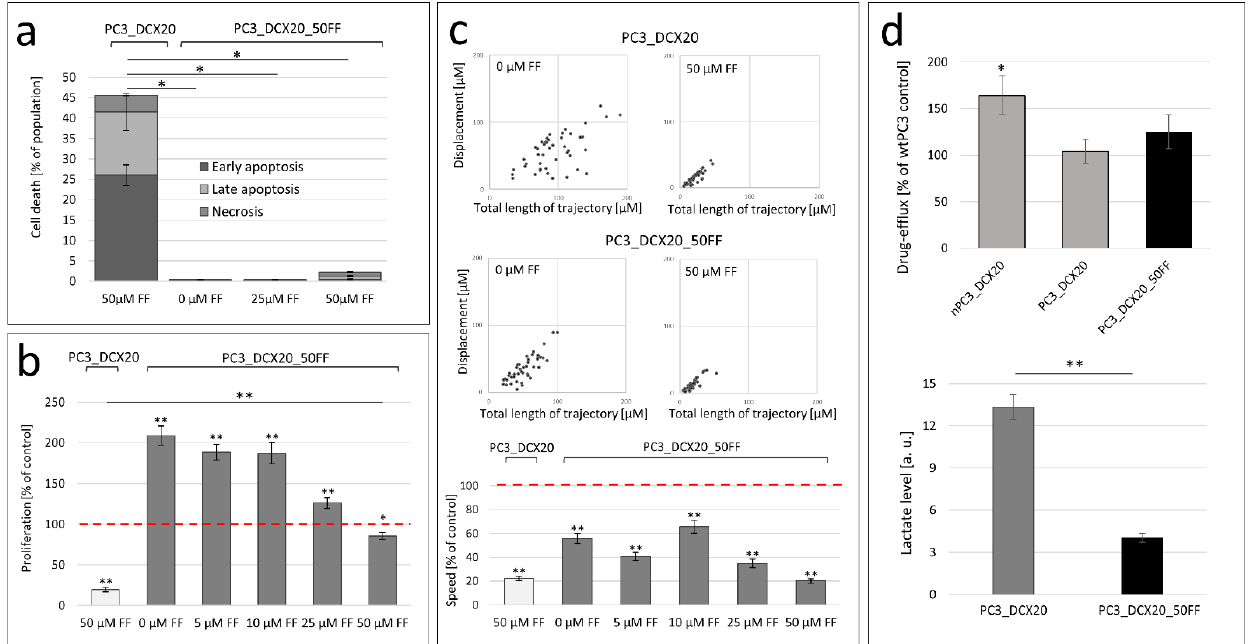
Figure 4. Sensitivity of PC3_DCX20_50FF cells to fenofibrate. ( a ) Apoptotic response